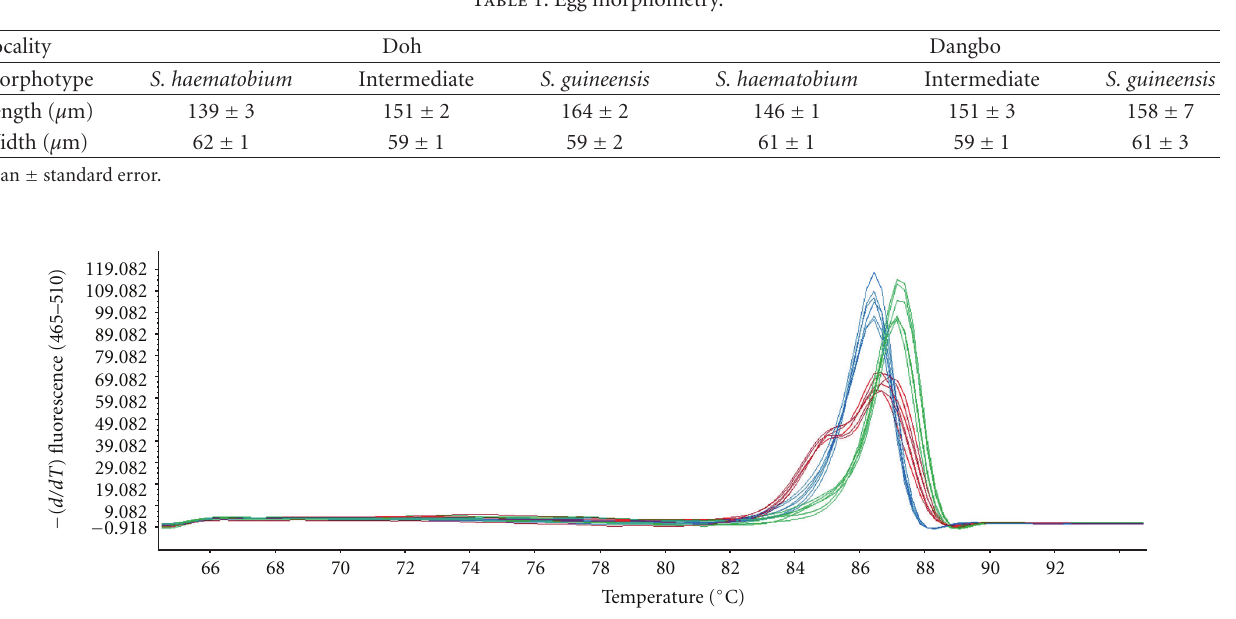
Figure 3: Results of the high resolution melting analysis. Melting peaks of 6 randomly selected individuals from the S. haematobium (green), hybrid (red), and S. guineensis (blue)